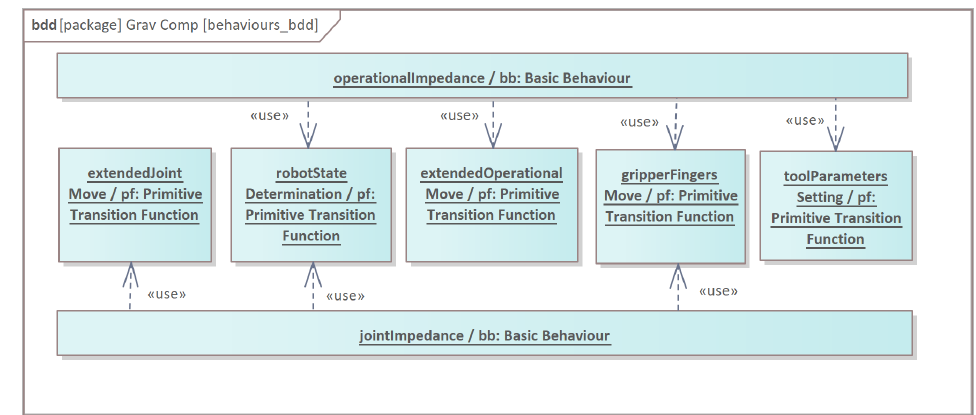
Figure 4. Basic behaviours relation to primitive transition functions in core/a.cs.